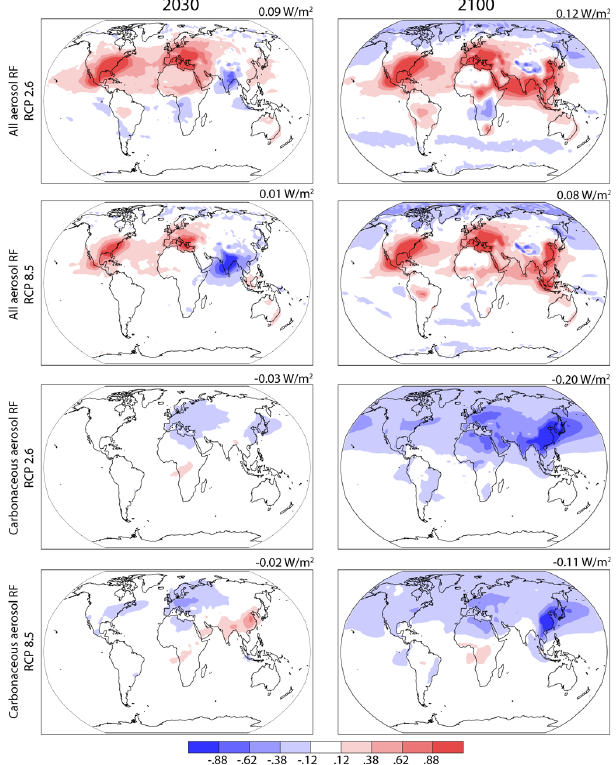
Fig. 14. All aerosol RF and carbonaceous aerosol RF for 2030 and 2100 relative to 2000 under RCP2.6 and